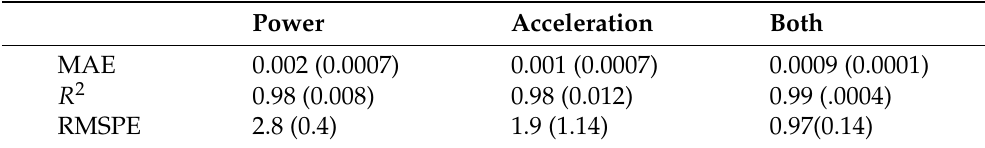
Table 9. Regression results for H2O DAI estimating the percentage of erosion showing the average and standard